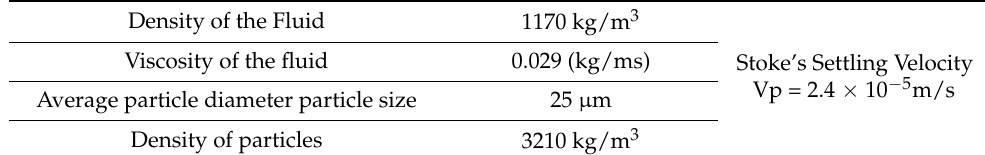
Table 4. Theoretical data for calculating Stoke’s settling velocity of SiC suspension in epoxy resin.